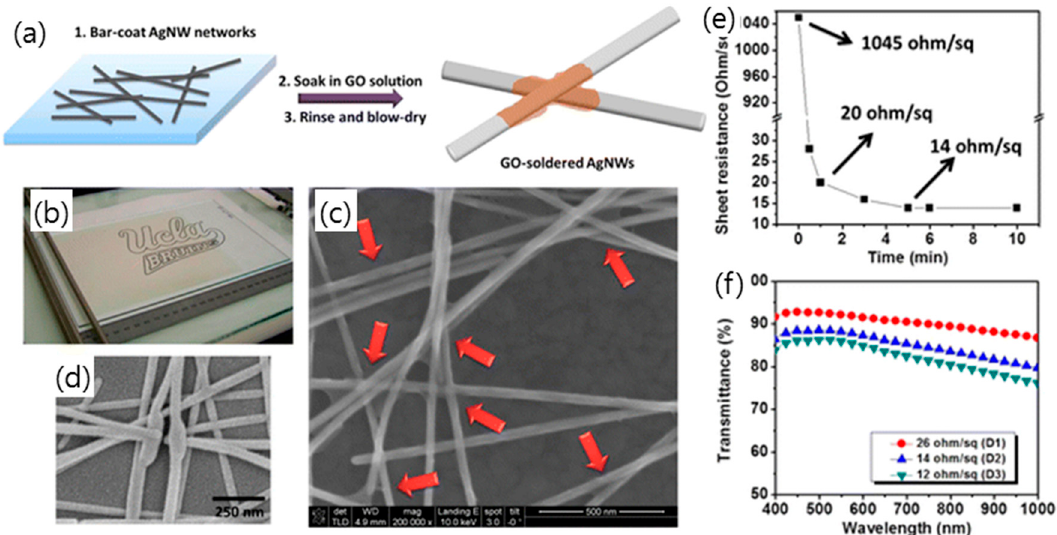
Figure 9. ( a ) Schematic illustration of the fabrication of a GO-AgNW network on a glass substrate at room temperature. ( b ) Optical photograph of a AgNW network bar-coated on a drawdown machine. SEM images of ( c ) GO-soldered AgNW junctions (indicated by red arrows) and ( d ) typical high-temperature fused AgNW junctions. ( e ) Measured sheet resistance of a GO-AgNW network as a function of the soaking time in a GO solution. ( f ) Transmittance spectra of GO-AgNW networks with three different AgNW densities (D1, D2, and D3). Reproduced with the permission of Reference [130]. Copyright 2014, American Chemical